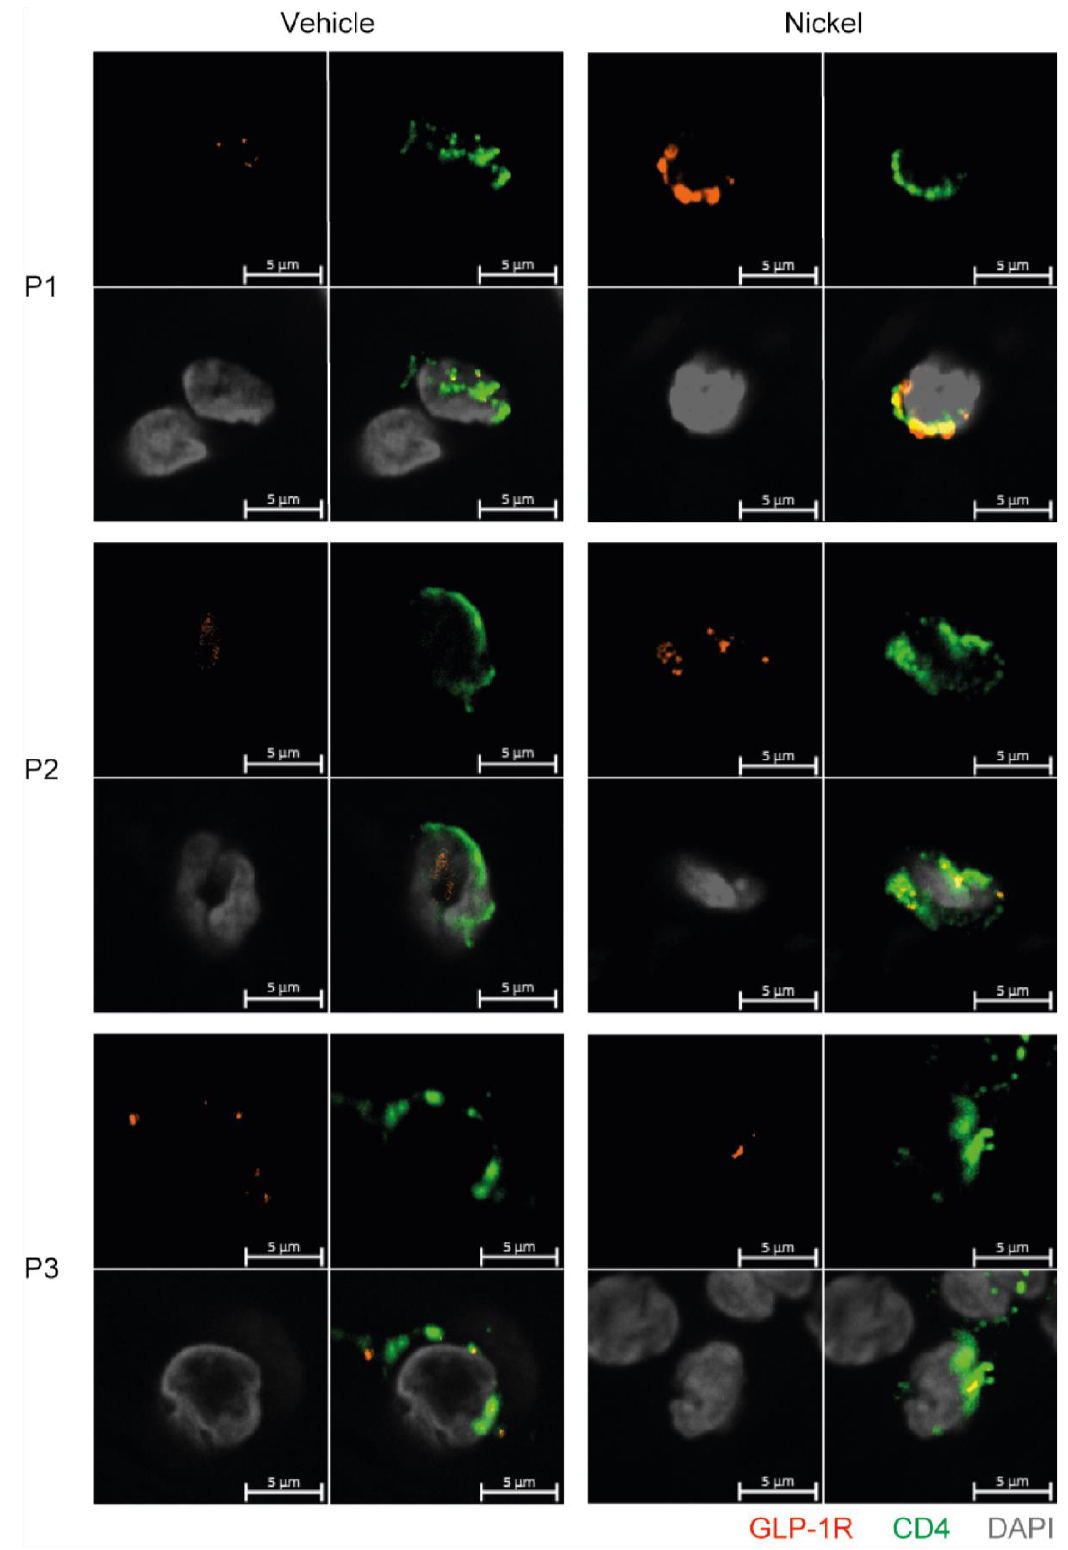
Figure 6. GLP-1R + CD4 + T cells are found in the skin. First quadrant GLP-1R (red), second quadrant CD4 (green), third quadrant DAPI (grey) and fourth quadrant merged stained fluorescent microscopy images of vehicle-exposed (Vehicle) and nickel-exposed (Nickel) skin from patients with allergic contact dermatitis to nickel. Representative images from three patients (P1, P2,